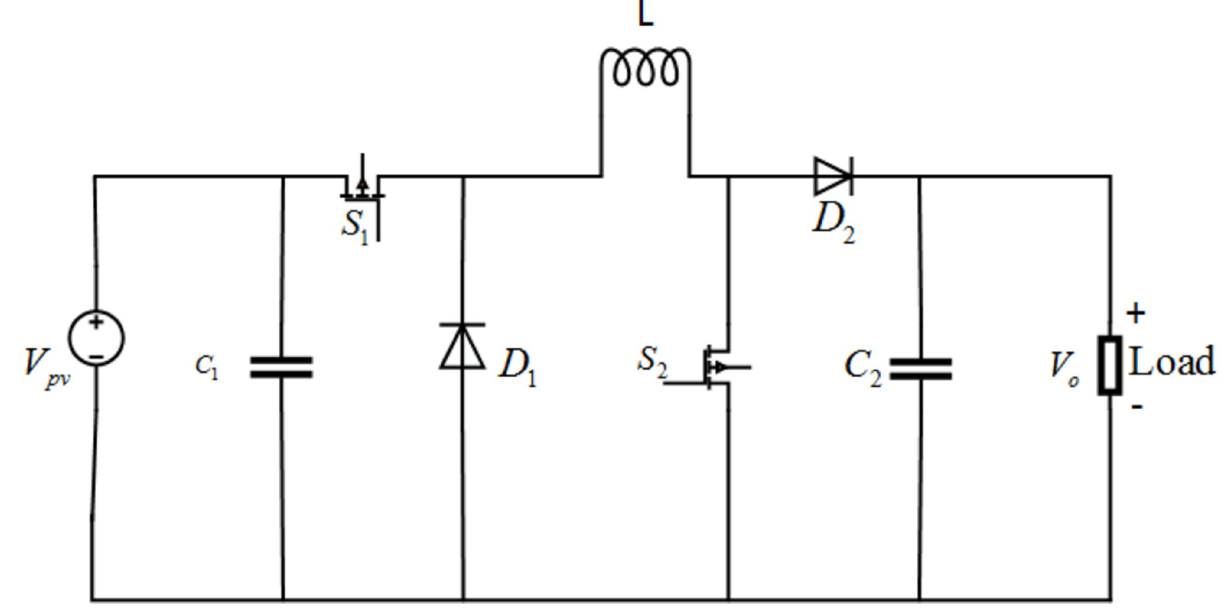
Fig 4. Circuit diagram of non-inverted buck boost